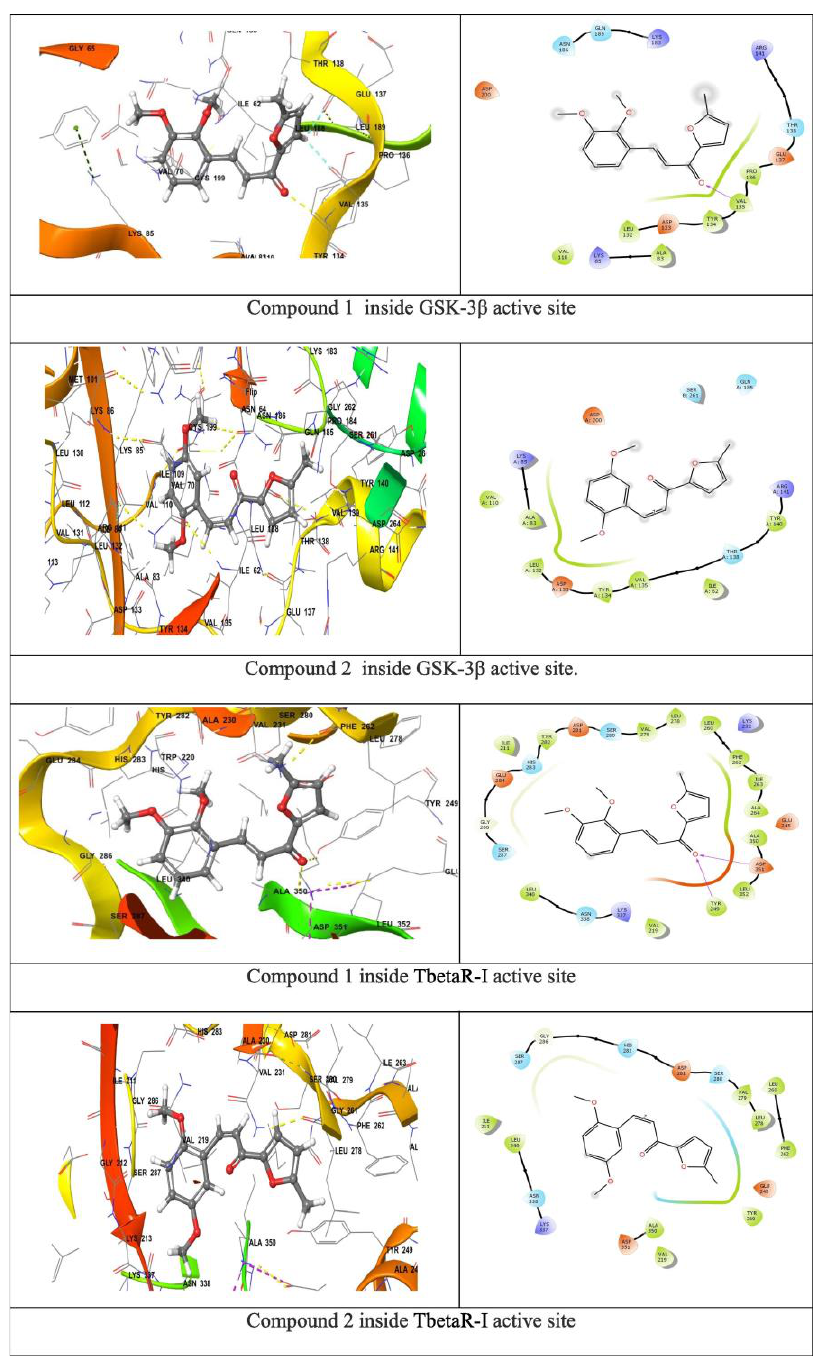
Figure 4. Different curcumin derivates depicting similar high binding affinity inside transforming growth factor beta type 1 kinase domain (TGF- β) and glycogen synthase kinase-3 beta (GSK3- β ) active sites observing their role in wound healing (reprinted with permission [56] from Elsevier).